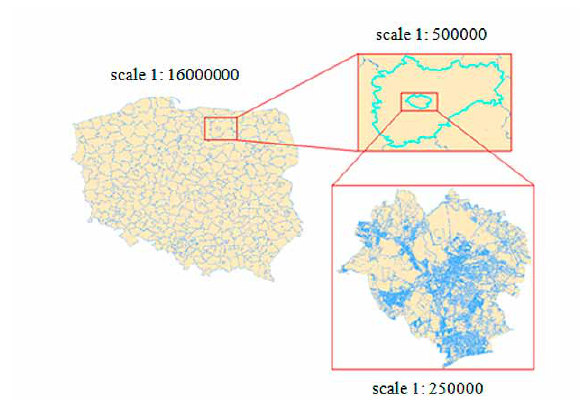
Fig. 2. Research area – Poland, Warmia-Masuria Province, Olsztyn Municipal Commune Source : own study.